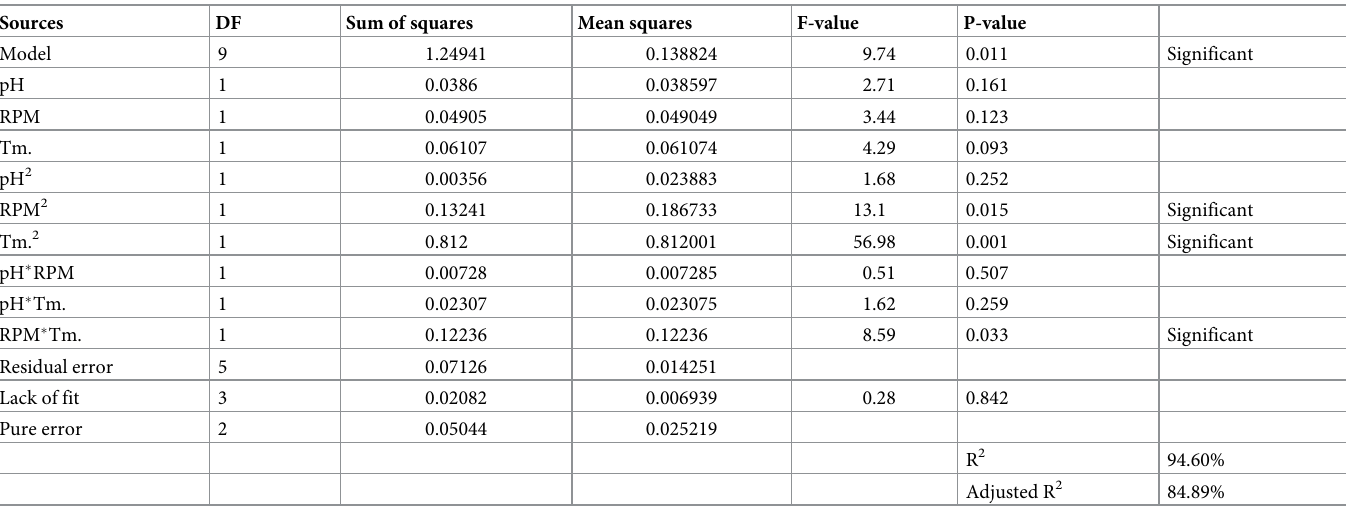
Table 3. Estimated regression coefficients for ABTS free radical scavenging ability-IC 50 .